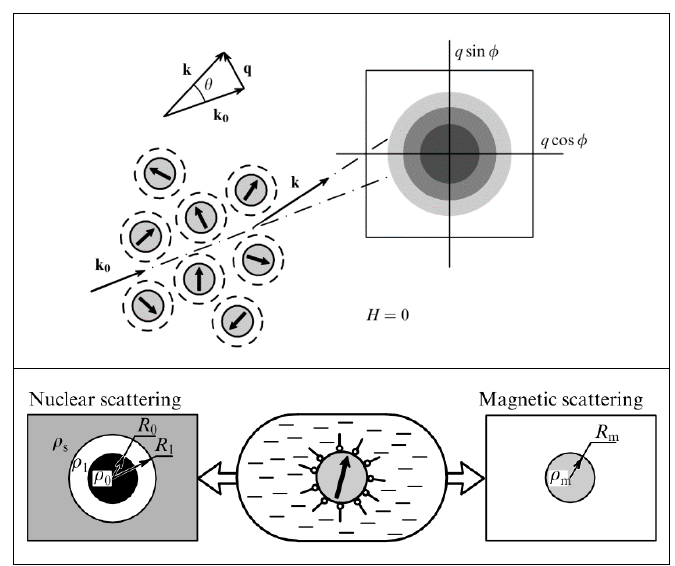
Figure 15. Top : Colloidal magnetic particles subjected to a beam with wave vector k 0 in the absence of an external magnetic field. Magnetic moments of the particles have arbitrary directions, and the scattering pattern is isotropic. Bottom : Model representation for the nuclear and magnetic particle structures in a magnetic fluid. R 0 is the physical size of the core, and R 1 is the radius of the shell/coating. The parameters 0 , 1 , and s are the nuclear scattering length densities of the core, shell, and solvent, respectively. m is the scattering length density for the magnetic part, having a radius R m . (Reprinted with permission from [229]. Copyright Uspekhi Fizicheskikh Nauk 2010).